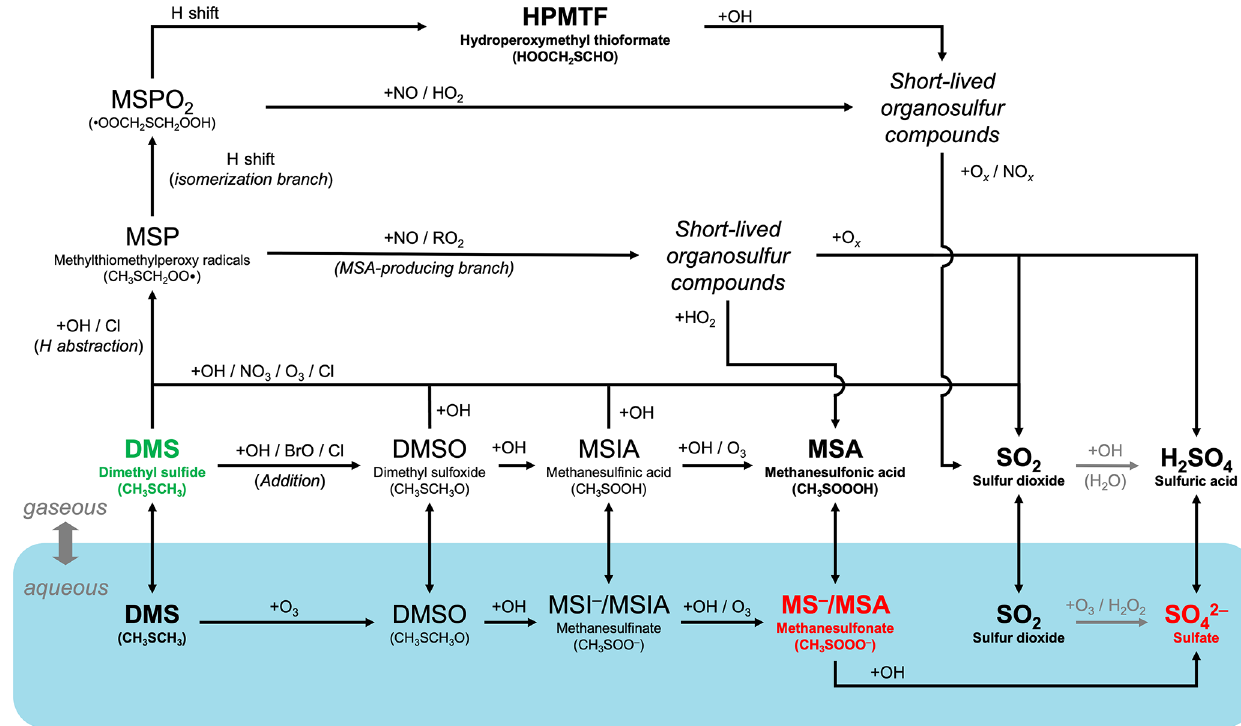
Figure 1. A schematic summary of our expanded atmospheric chemistry of DMS oxidation in CAM6-chem (Tables 4, 5, 6, and 7). Key relatively long-lived species (DMS, MSA, HPMTF, SO 2 , and sulfate), with lifetimes of > 0.5d, are highlighted in bold. The blue shadings denote species and reactions in the aqueous phase in interstitial aerosols and cloud droplets. DMS (highlighted in green) can undergo O-atom addition (rightward path) or H abstraction (upper paths). The H-abstraction channel further diverts into the isomerization branch (top path) and the MSA-producing branch. SO 2 is the dominant product of most gas-phase pathways, while MSA is formed mainly via the aqueous- phase oxidation of DMS. Oxidation of SO 2 to sulfate or sulfuric acid is handled by the CAM6-chem standard chemistry. The resultant particulate MSA and sulfate (highlighted in red) are key species with important radiative impacts.